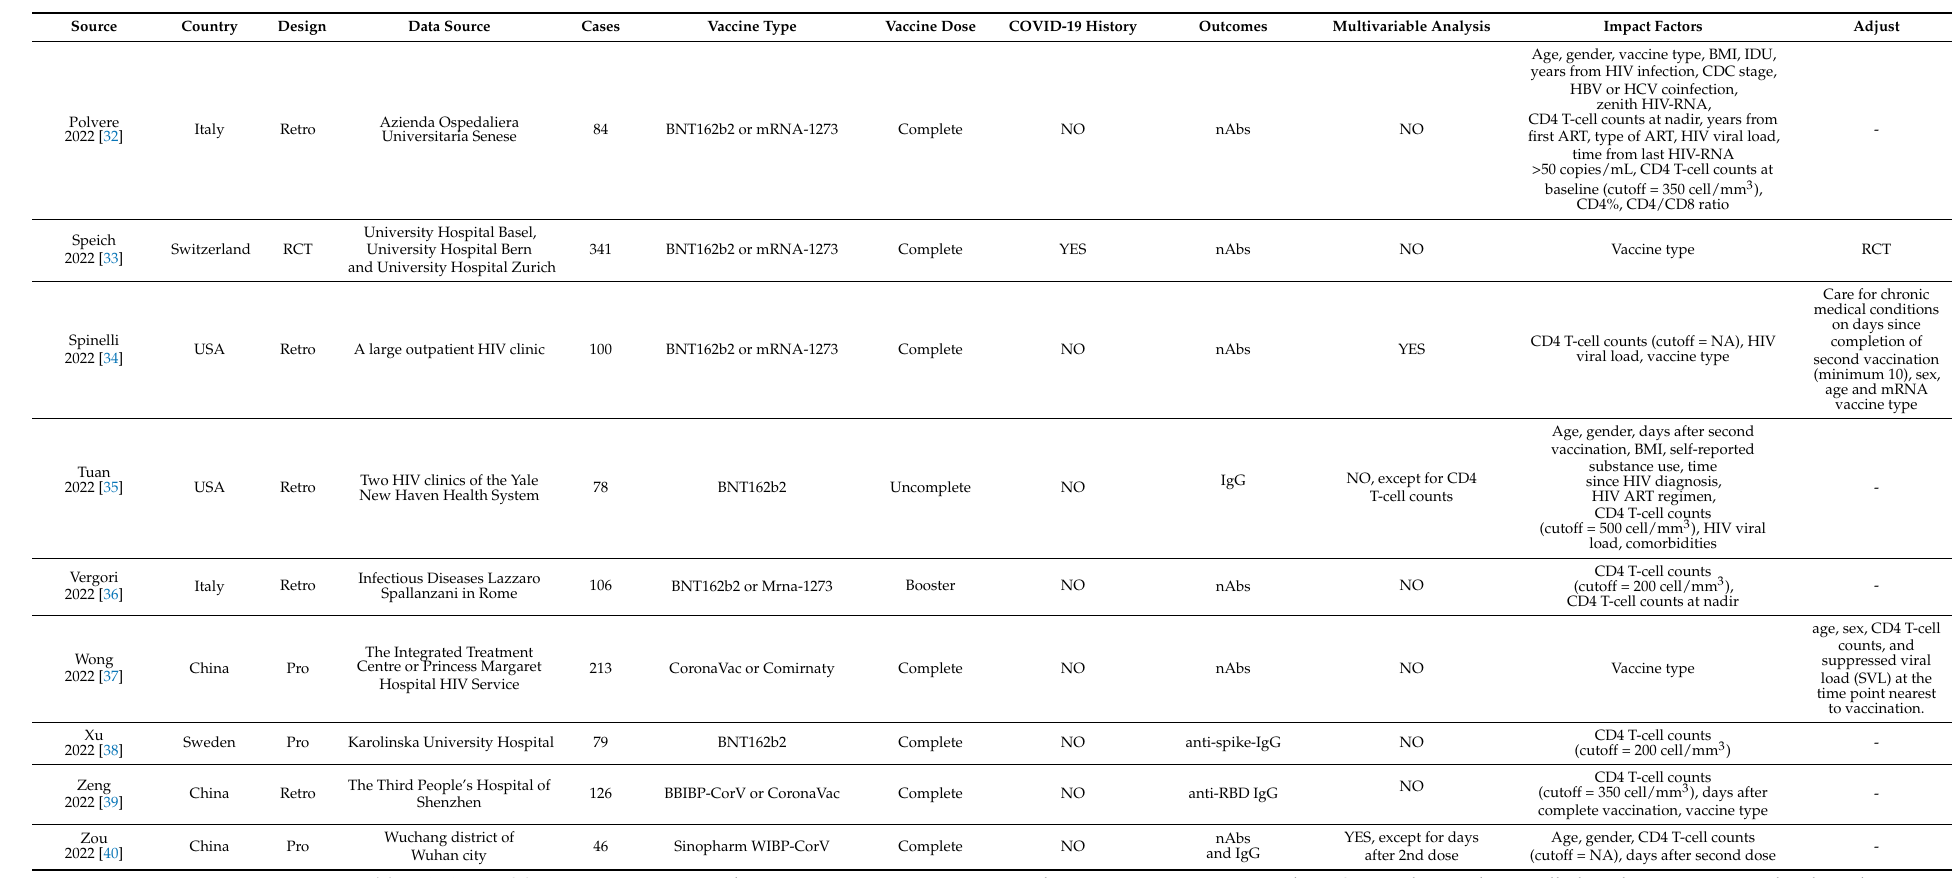
Abbreviations: COVID-19, coronavirus disease 2019; Pro, prospective study; Retro, retrospective study; RCT, randomized controlled trial; RBD, receptor binding domain; Ig, immunoglobulin; S, spike; nAbs, neutralizing antibodies; BMI, body mass index; MBC, memory B cell; BV, hepatitis B virus; HCV, hepatitis C virus; IDU, injecting drug users; NA, not